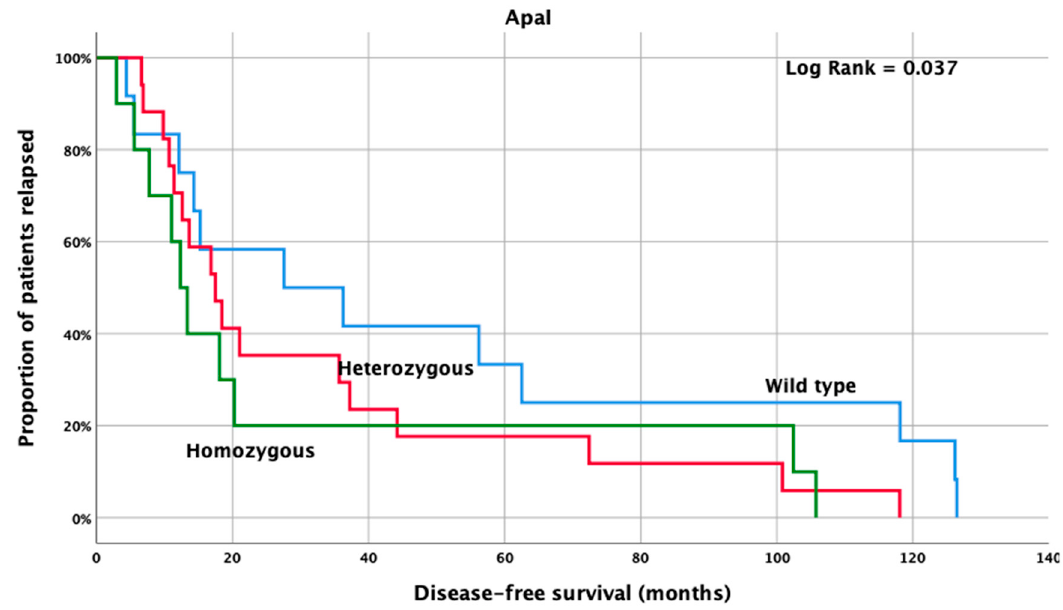
Figure 2. Kaplan Meier curve for disease-free survival according to VDR - Apa I genetic variants, in stage III CRC patients.